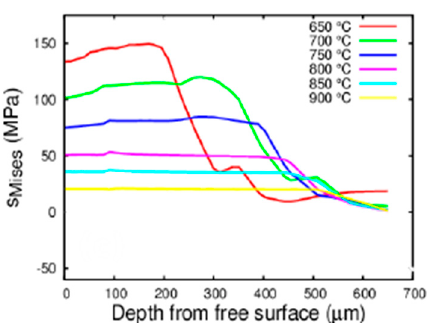
Figure 15. Quantitative effect of bed pre-heating temperature on residual stresses, where SMises is the Von Mises Stress. Adapted from [117], with permission of Elsevier, 2016.